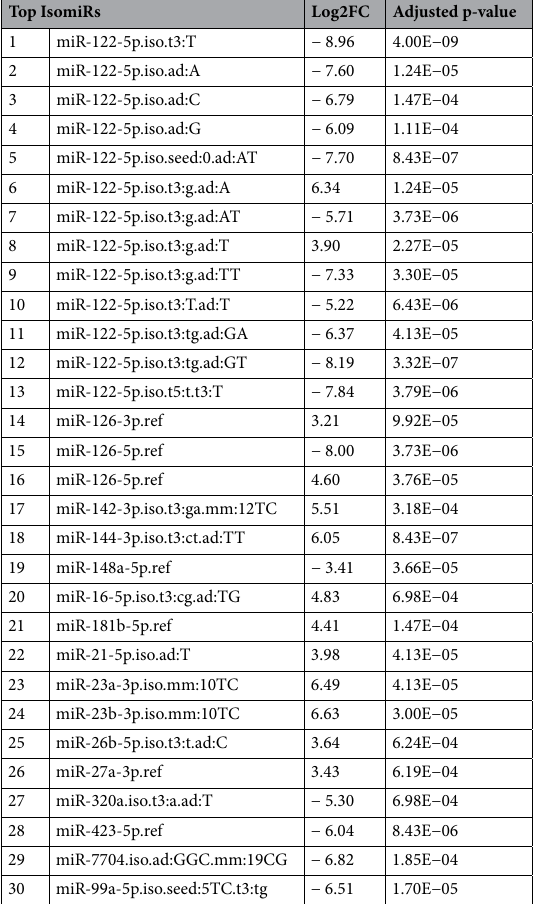
Table 3. Top 30 differentially expressed isomiRs in the hepatic